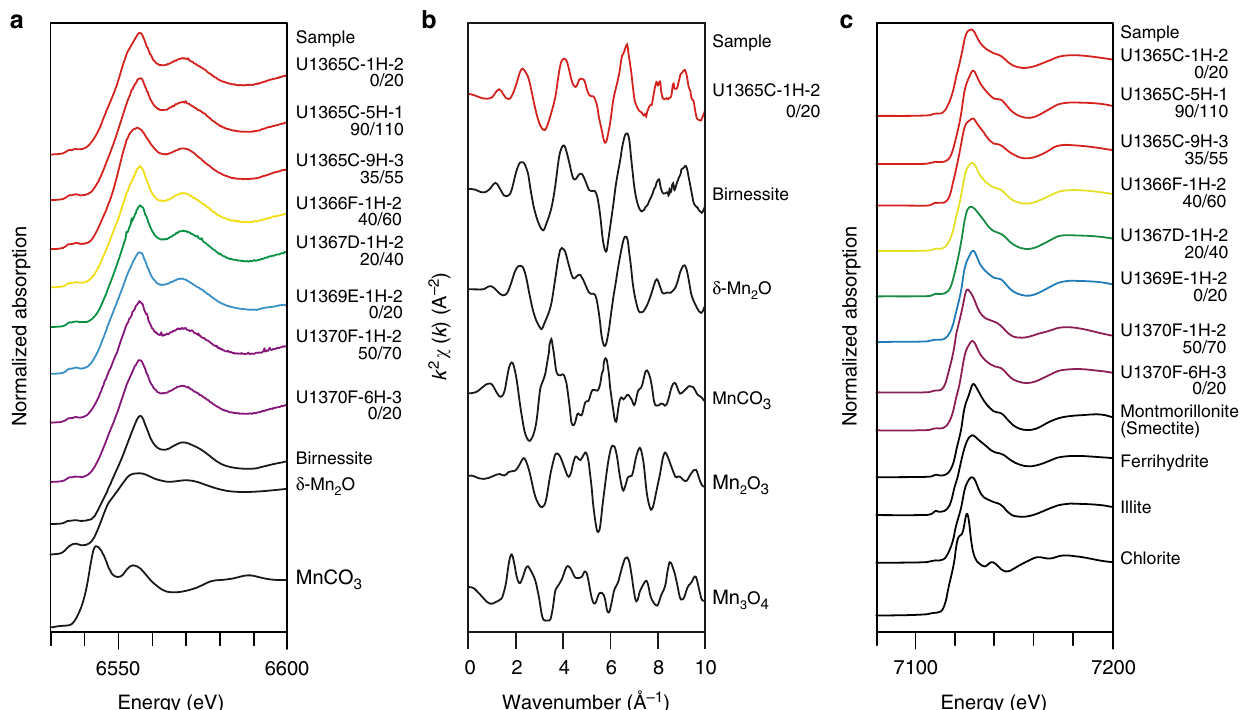
Fig. 5 Spectroscopic characteristics of bulk samples in this study. a , b X-ray absorption fi ne structure (XAFS) results for selected bulk samples and standard samples at the Mn K-edge: a X-ray absorption near edge structure (XANES) spectra of selected and standard samples, b representative normalized k 2 -weighted extended XAFS spectra for sample U1365C-1H-2 0/20 and standard samples. c XANES spectra of selected and standard samples at the Fe